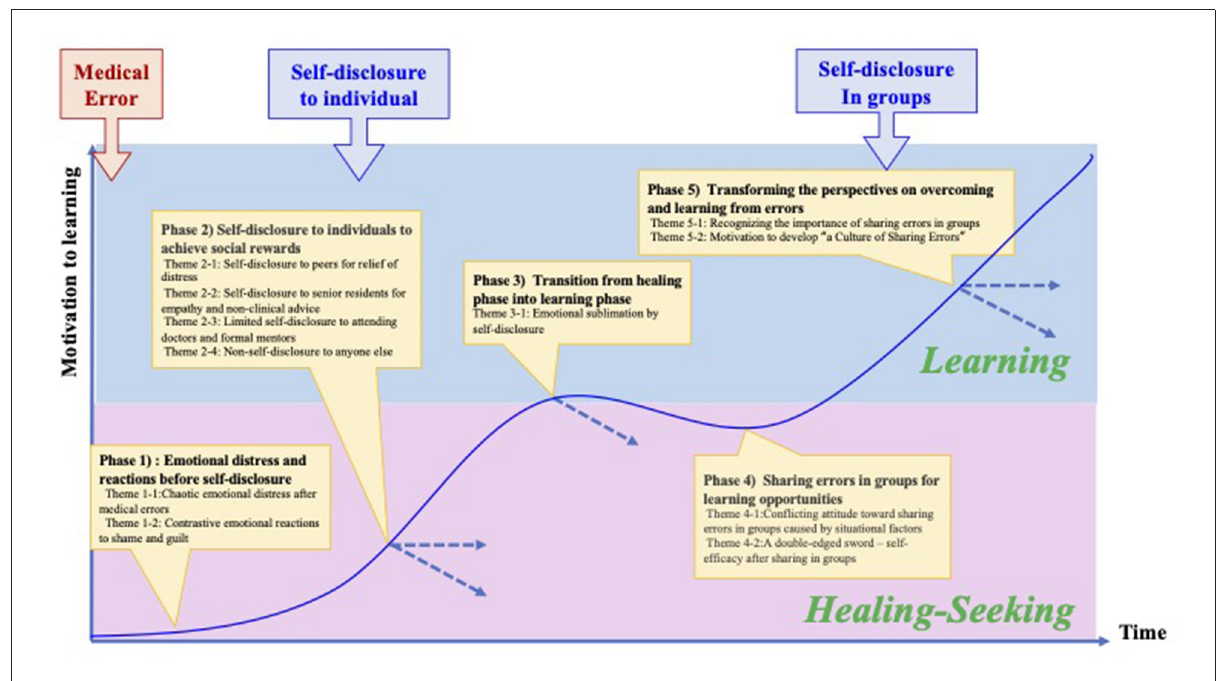
FIGURE1 The shifting processes of residents’ coping process, revealed through